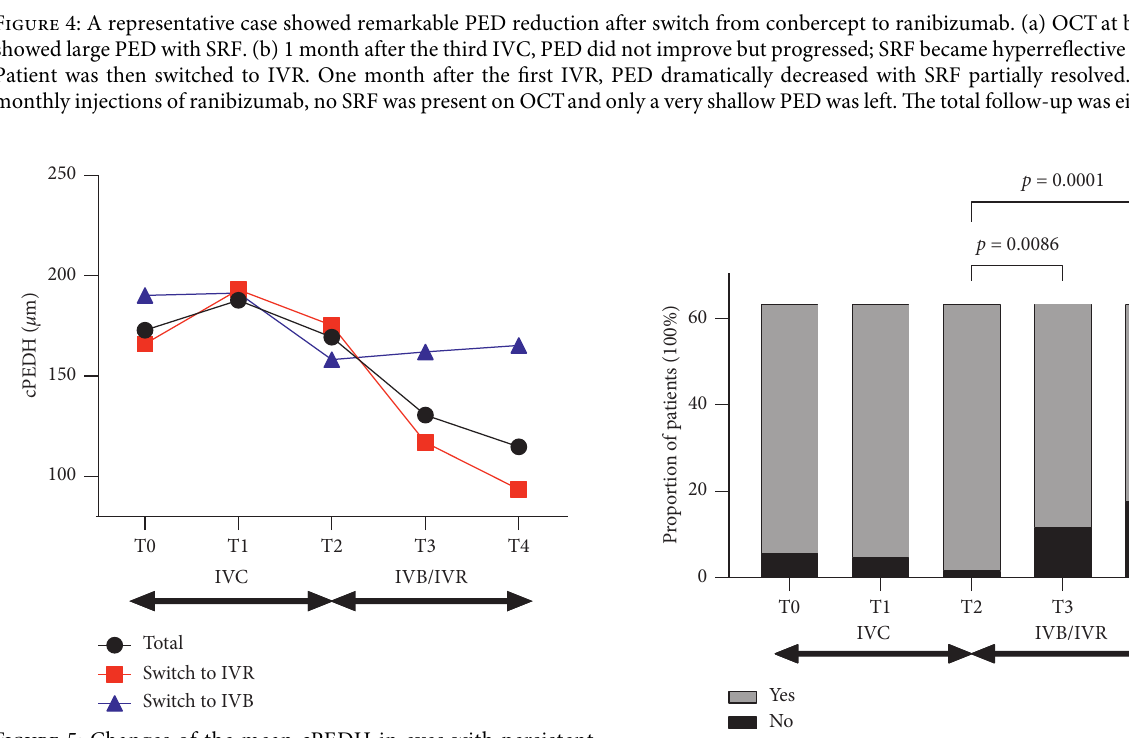
Figure 6: Changes in proportion of patients have IRF on SD-OCT. The proportion of patients with IRF did not change statistically sig- nificantly during the treatment of IVC. After switching to IVR or IVB, this proportion decreased significantly from 96.9% to 81.3% at T3 and 71.9% at T4. IRF, intraretinal fluid; IVC, intravitreal injections of conbercept; IVB, intravitreal injection of bevacizumab; IVR, intra- vitreal injection of ranibizumab; T0, baseline visit; T1, 1 month after the first ICV; T2, 1 month after 3 monthly IVC; T3, 1 month after the first IVR or IVB; T4, 1 month after the last IVR or